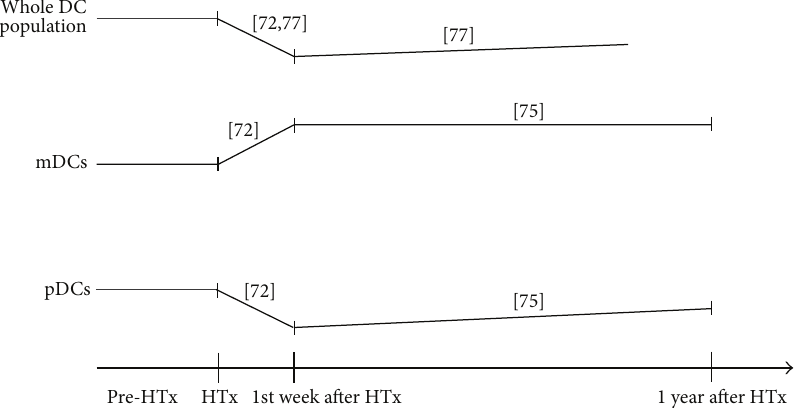
Figure 1: Changes of dendritic cells and their subsets following heart transplantation. Increases and decreases of the whole DC population and the subsets mDCs and pDCs following heart transplantation were visualized. The appropriate references were added in squared brackets. DCs: dendritic cells; HTx: heart transplantation; mDCs: myeloid dendritic cells; pDCs: plasmacytoid dendritic cells.